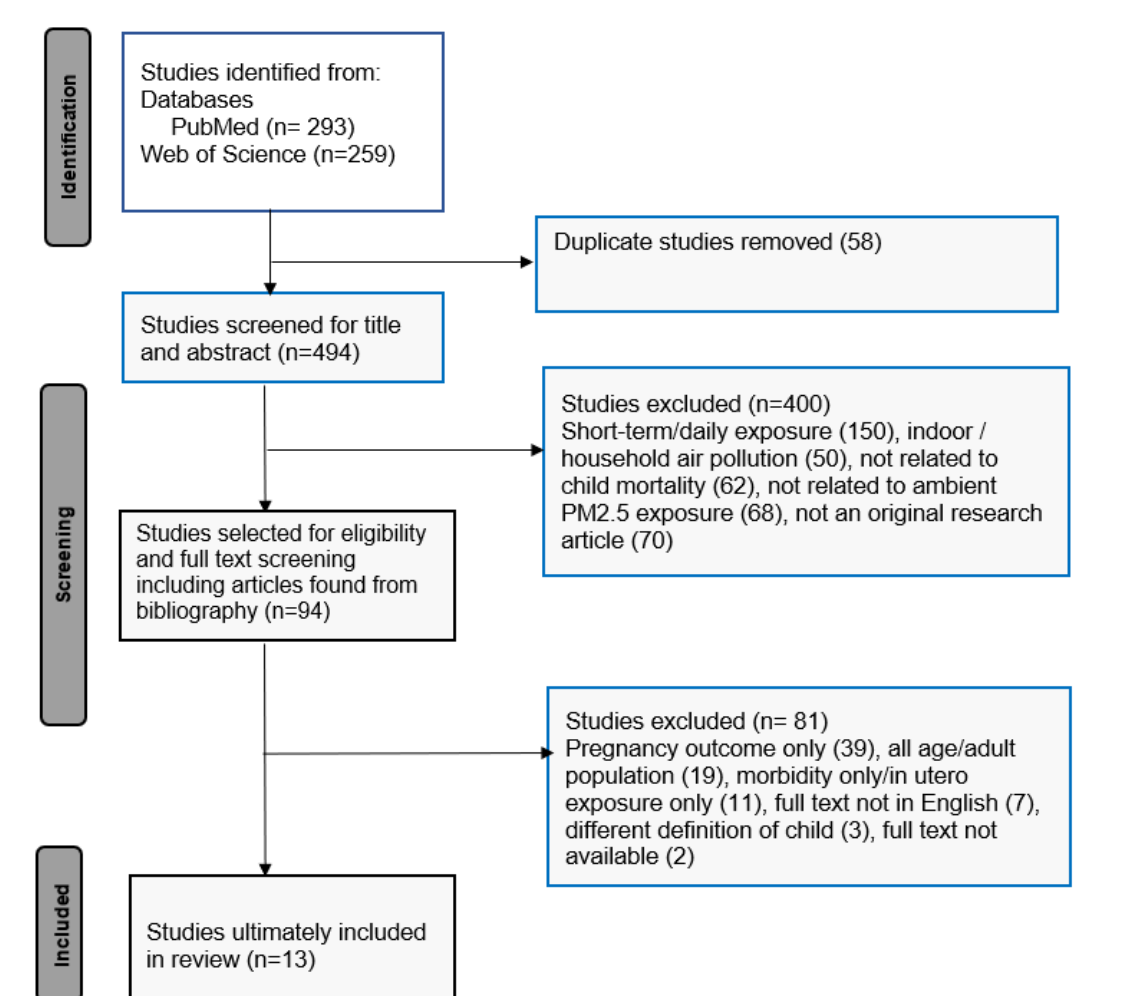
Figure 1. Flowchart of selection process.